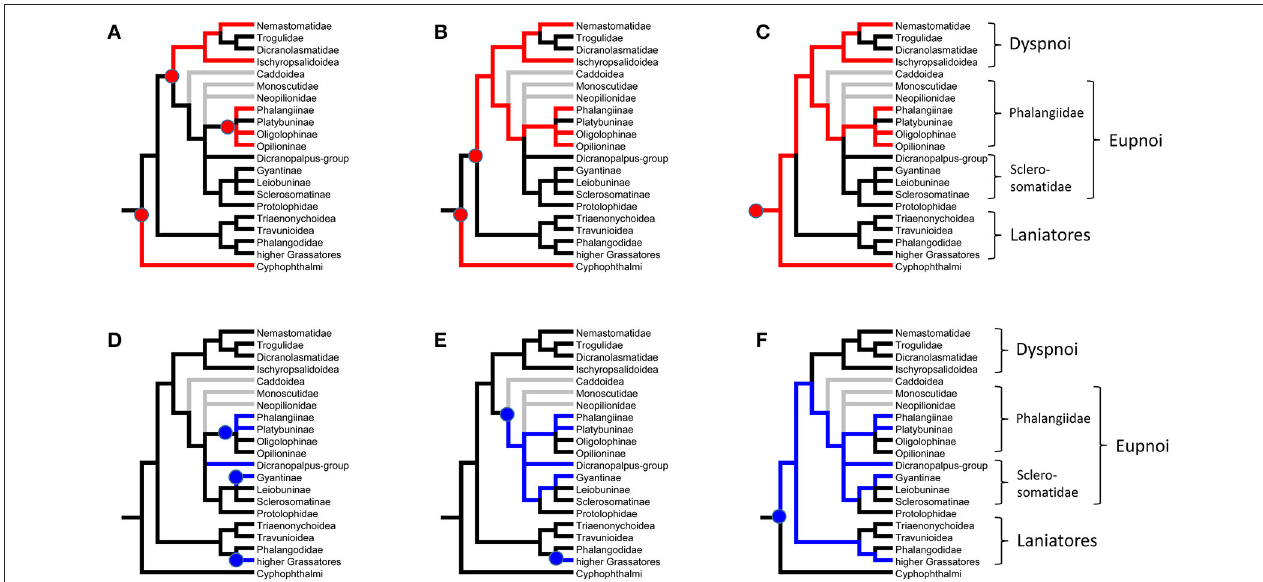
FIGURE 2 | Eligible hypotheses for the evolution of quinones in the scent glands of Opiliones. In Red: Naphthoquinones. (A) Multiple independent evolution in Cyphophthalmi, Dyspnoi, and phalangiid Eupnoi. (B) Independent evolution in Cyphophthalmi and Palpatores. (C) Common ancestry. In Blue: Benzoquinones. (D) Multiple independent evolution in Gonyleptoidea (higher Grassatores), sclerosomatid Gyantiinae, Dicranoplalpus -group, and Phalangiidae. (E) Independent evolution in Palpatores and Gonyleptoidea (higher Grassatores). (F) Common